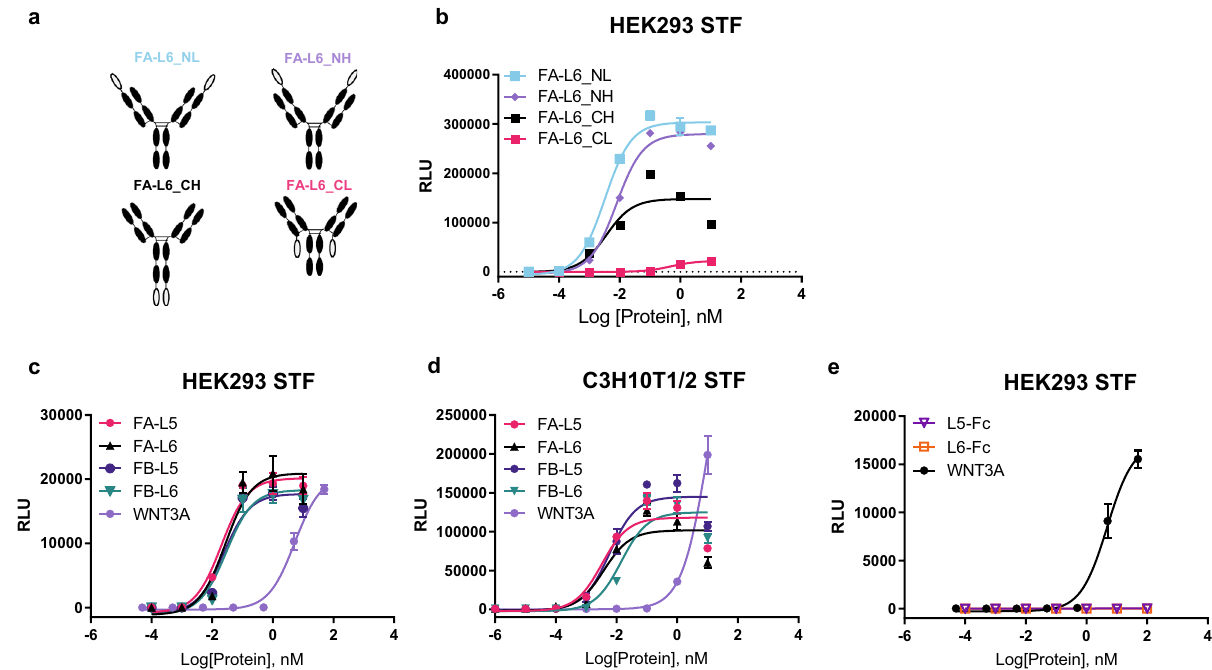
Fig. 4 In vitro characterization of Wnt mimetic molecules. a Diagram of the tetravalent bi-speci fi c Wnt mimetic formats. VHH domain is represented by the open oval symbol and IgG by the black- fi lled oval symbol. b – e Wnt signaling STF activity is represented by relative luminescence units (RLU). b The dose-dependent STF activities of the four different VHH-IgG fusion mimetics shown in a . c Dose-dependent STF activities of the FA-L5, FA-L6, FB-L5, FB- L6, and WNT3A in HEK293 cells. d Dose-dependent STF activities of FA-L5, FA-L6, FB-L5, FB-L6, and WNT3A in C3H10T1/2 cells. e Dose-dependent STF activities of L5-Fc, L6-Fc, and WNT3A in HEK293 cells. Data are representative of three independent experiments performed in triplicates and are shown as mean ±